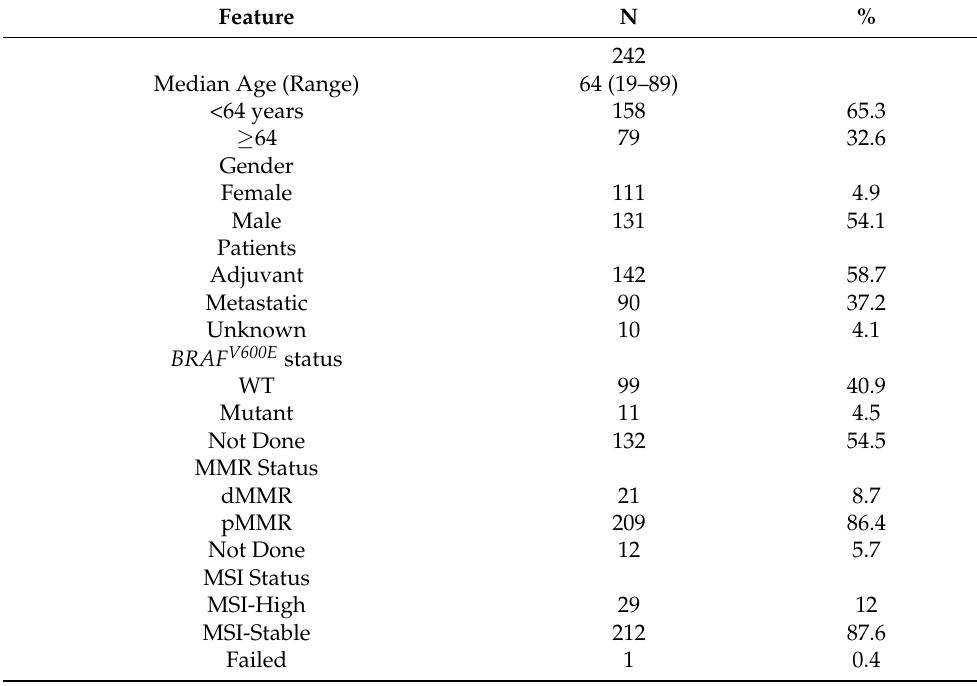
Table 1. Clinical characteristics and pathological